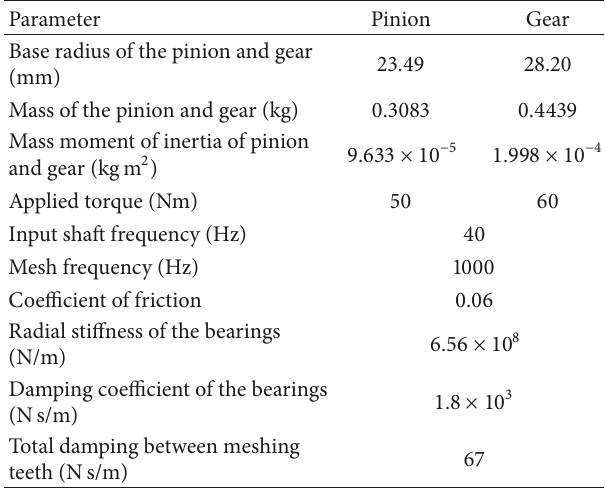
Table 4: Parameters of the gear system used in the dynamic model